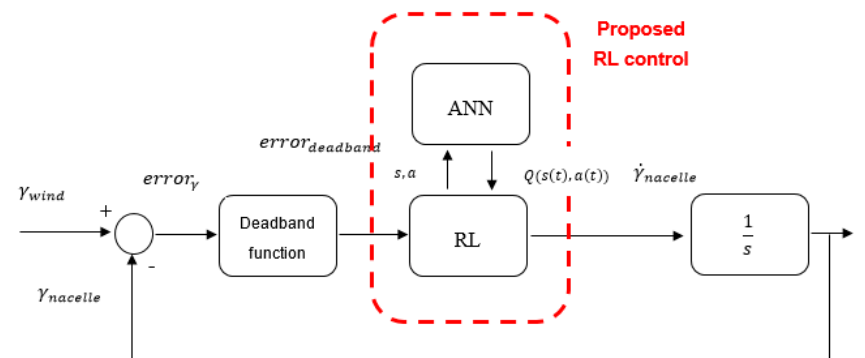
Figure 10. Block diagram of the proposed RL based yaw control system.